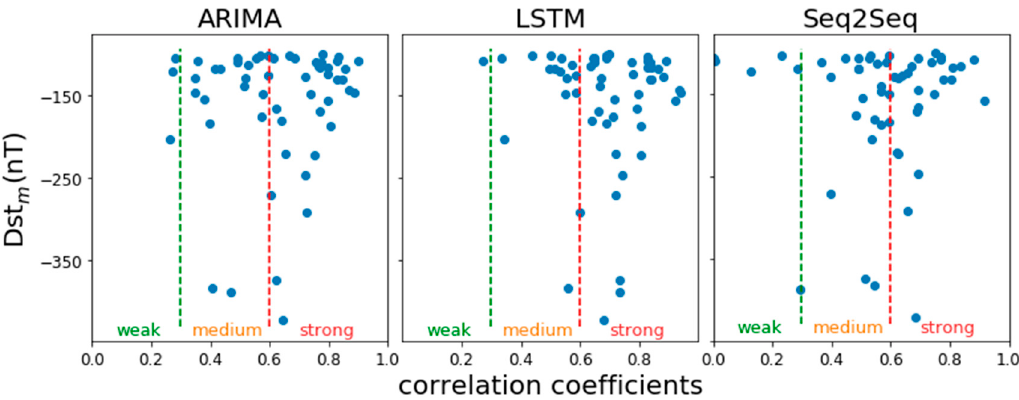
Figure 9. The relationship between the prediction results of the three methods and the observed values under different geomagnetic storm intensities (shown by blue points). The y-axis Dstm is the same as that of Figure 5, and the x-axis is the correlation coefficient (CC) between each observation and the predicted data. The weak region (CC < 0.3) represents a weak correlation between the predicted value and the observed data. Similarly, medium (0.3 ≤ CC < 0.6) means moderately correlated, while strong (CC ≥ 0.6) is strongly correlated.